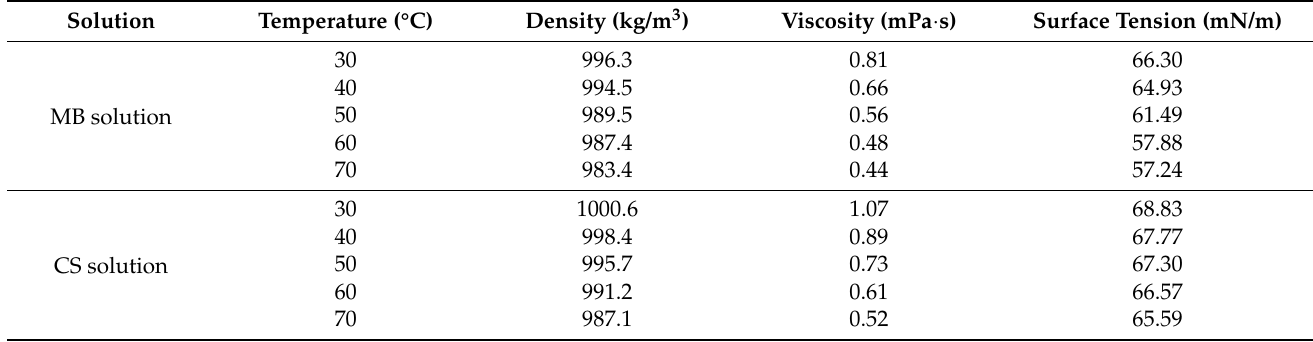
Table 1. Physical properties of MB solution and CS solution at different